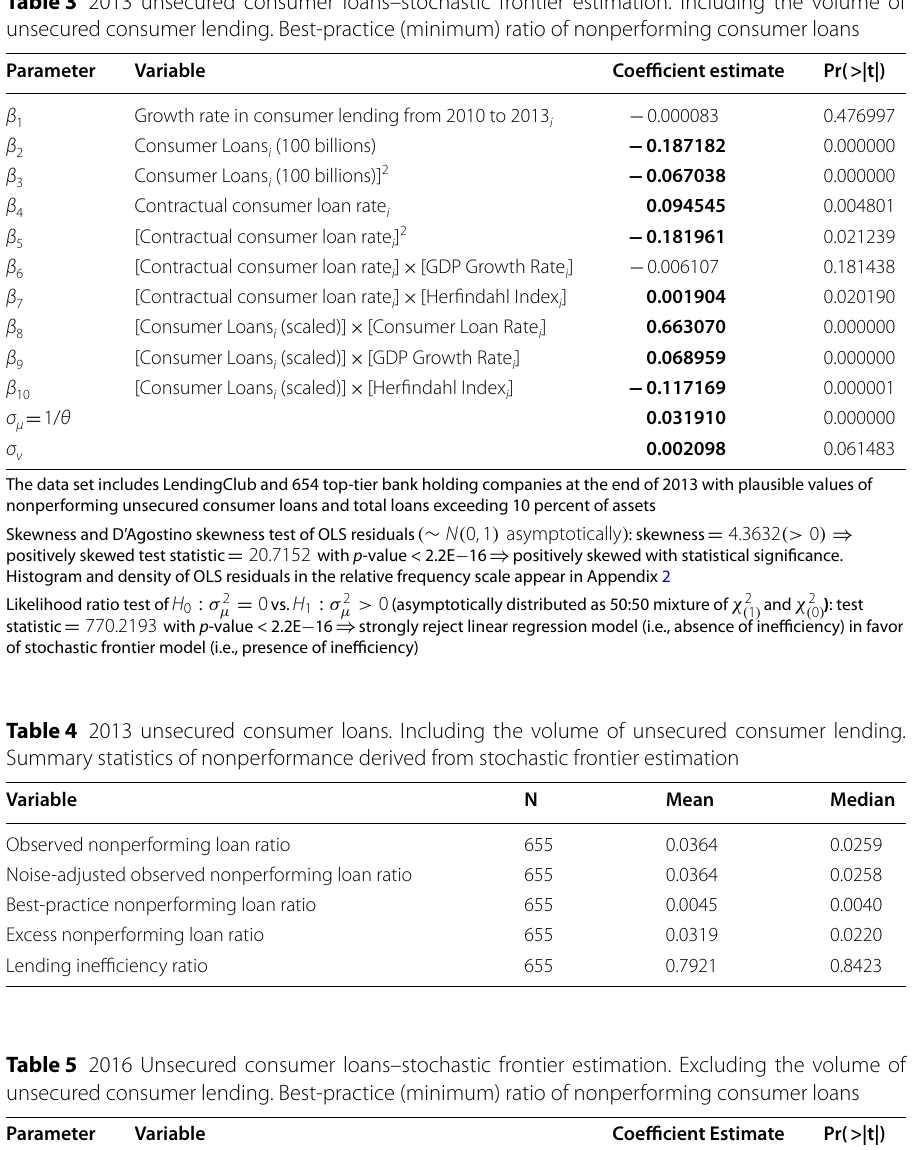
Table 3 2013 unsecured consumer loans–stochastic frontier estimation. Including the volume of unsecured consumer lending. Best‑practice (minimum) ratio of nonperforming consumer loans